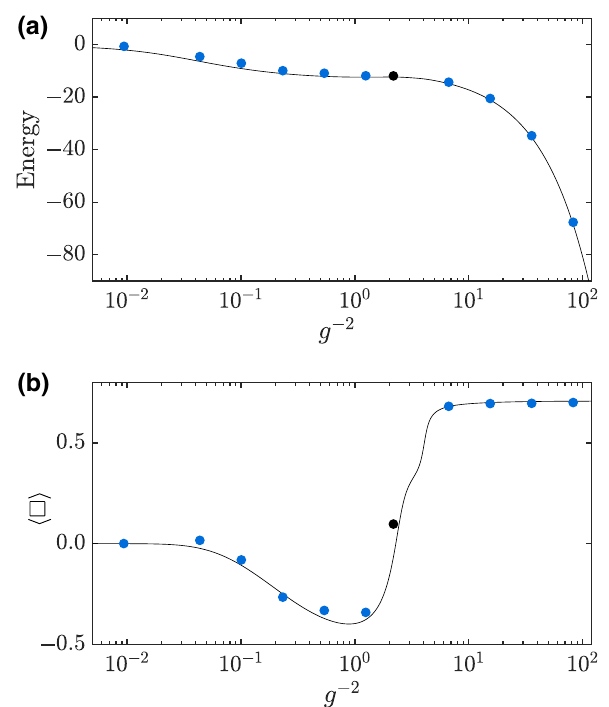
FIG. 5. The classical simulation of the proposed experiment for observing the dynamical generation of magnetic fields where (cid:4) = 5 and m = 0.1 (see Sec. V A), using the circuits given in Fig. 4. The blue and black dots represent data points obtained by variational minimization with a total finite measurement bud- get of 10 7 measurements for the entire plot. Half of this budget is spent for the black dot alone. The black solid lines are deter- mined via exact diagonalization of the Hamiltonians in Eqs. (13). (a) The energy of the variational ground state. (b) The plaque- tte expectation value (cid:8) (cid:2) (cid:3) as a function of g − 2 . All dots are calculated using the exact state corresponding to the optimal variational parameters found by the VQE.